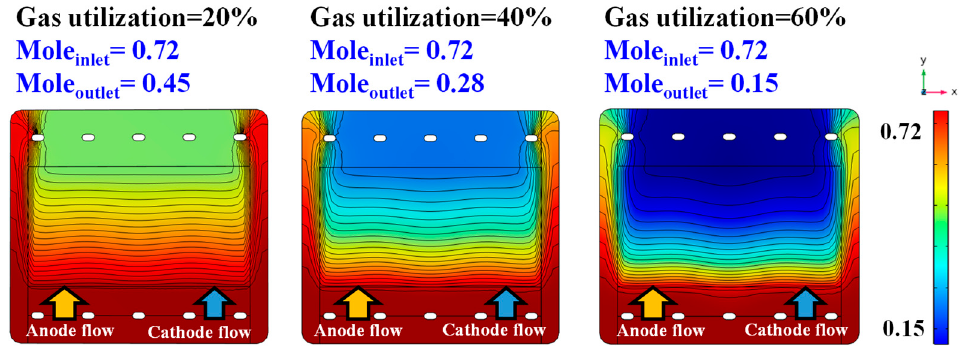
Figure 9. Hydrogen distribution according to the gas utilization.